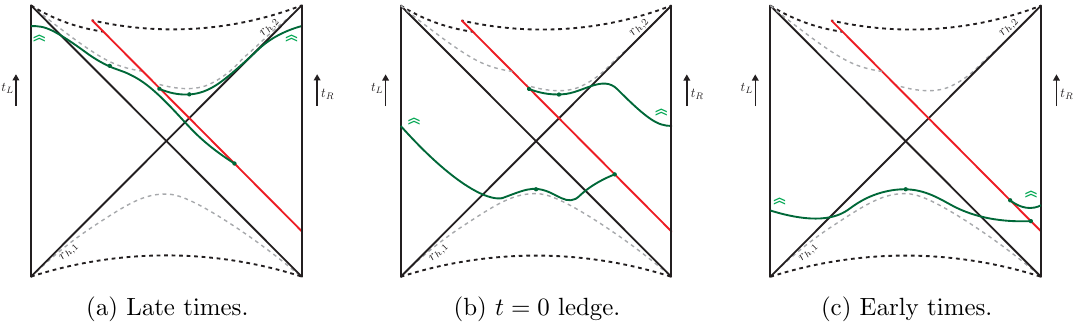
Figure 14. The shape of the surface in the various limits discussed in eqs. (4.22), (4.23), (4.25) for symmetric time evolution t L = t R = t= 2 after an early